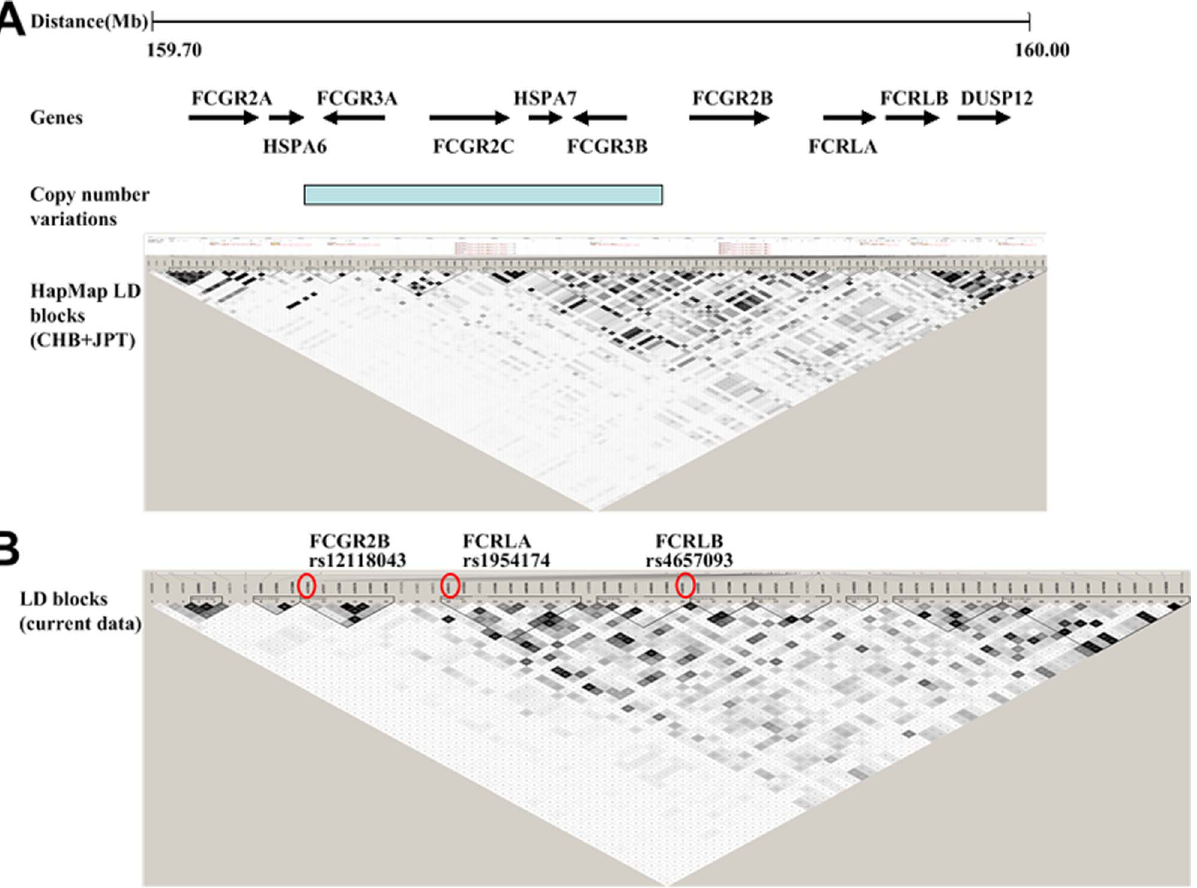
Figure 1. Lack of extensive haplotype blocks with FCGR gene loci in 1q23. ( Figure 1A ) The linkage disequilibrium (LD) blocks were derived from the HapMap3 Asian CHB and JPT dataset (http://www.hapmap.org). CHB: 80 Han Chinese from Beijing, China; JPT: 82 Japanese in Tokyo, Japan. The locus was complicated by multiple kinds of genetic variations including single-nucleotide polymorphisms (SNPs) as well as copy number variations with low linkage disequilibrium. ( Figure 1B ) The linkage disequilibrium (LD) blocks of SNPs in the current study. The SNPs associated with IgAN were marked by circle.